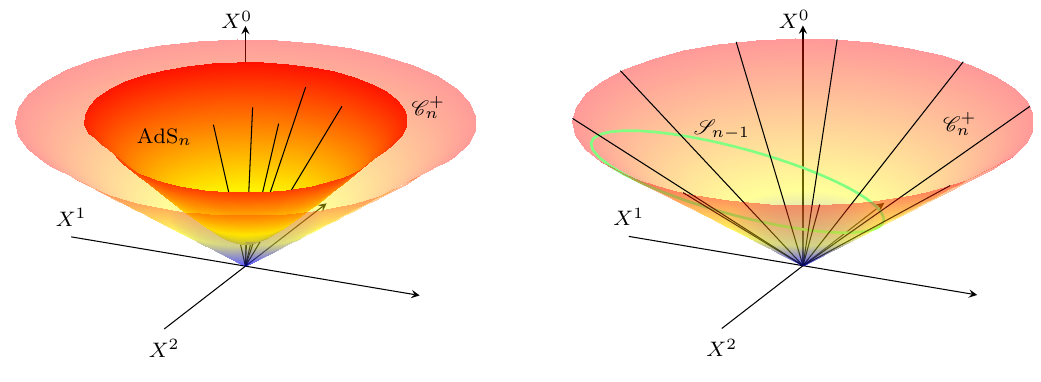
Figure 1 . Null cone and AdS n Figure 2 . Null cone and S n (cid:0) 1